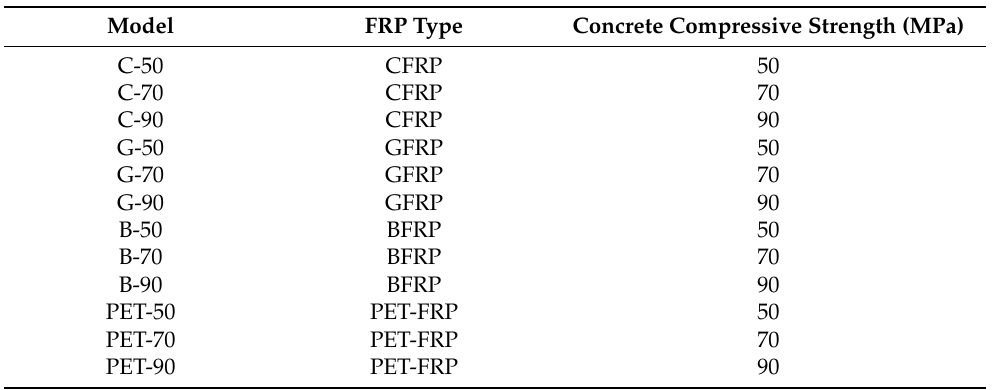
Table 3. Parametric study test